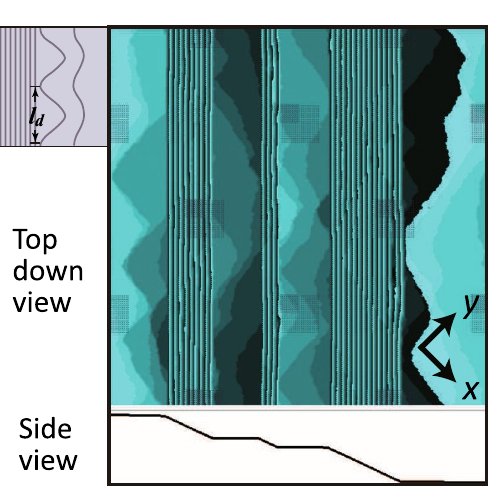
Figure 1. �µ dependence of the square of the surface width gW 2 , where �µ is the driving force for crystal p 3 √ 2 / 8 p 2 , where 0.530 is the mean surface slope. ǫ int /ǫ growth. g is 1 ¯ = + ¯ ≈ gW 2 , with a maximum value at �µ R ( L ) . The lines represent different sizes and are generated from Eqs. (6)–(12). 0.385 , which is the 2D KPZ roughness exponent in 3D. ( c ) Y ( x , L ) (Eq. (6)) gW 2 scaled by L α with α ( b ) = 0.25 . scaled by L α ′ with α ′ = (cid:31)